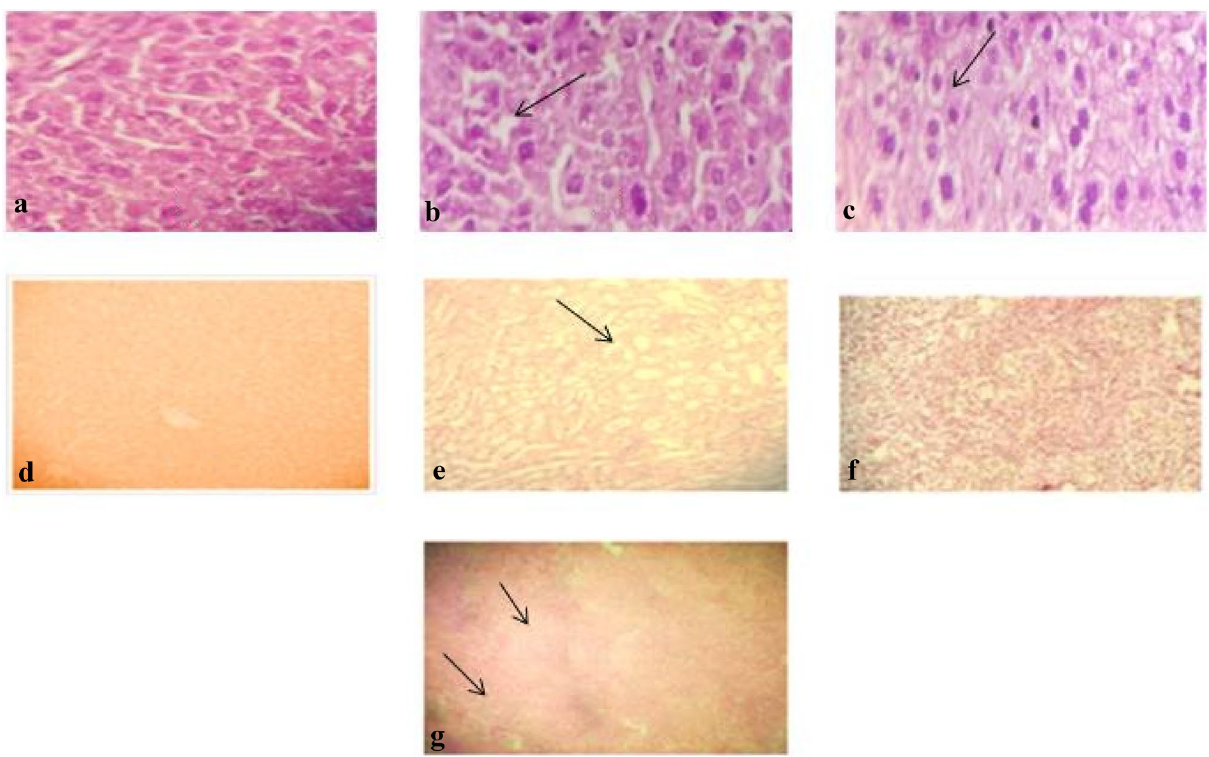
Figure 1. “ a ” showed the normal mice liver tissues, followed by “ b ” (arrow) showed the degeneration of hepatocytes. “ c ” presents recovery of degenerated hepatocytescaused by CCL 4 induction. “ d ” CCL 4 treated cellular structure of kidney. “ e ” DVM treated kidneyshowed slight recovery of renal tubules. “ f ” presents a normal spleen, while “ g ” arrow depicts normal lymphoid masses and red pulp in DVC-treated